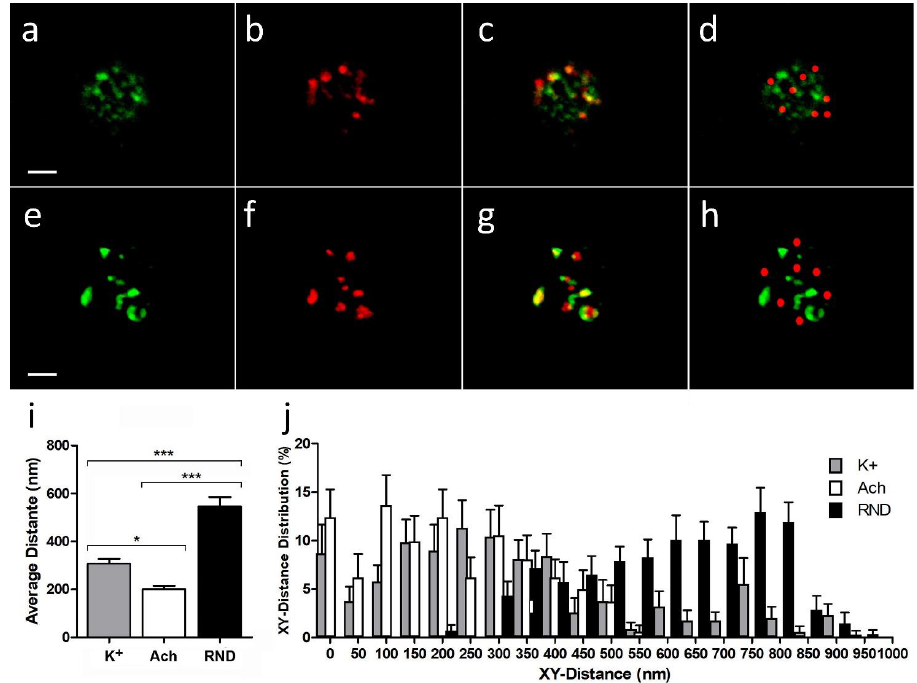
Figure 2. Membrane proximity between endogenous (real) or random simulated α3β4 nAChRs (red) and DBH exocytosis patches (green) upon K + or ACh secretion stimulus. α3β4 nAChR real struc- tures are apparently in contact with DBH exocytotic points more than what would be expected for a random distribution. ( a – d ) A chromaffin cell with both green DBH ( a ) and red α3β4 nAChR ( b ) immunolabeling in a secretion stimulus assay using depolarization with high K + (see Section 4.5). Many of the real α3β4 nAChR (red) structures seem to have at least one pixel that colocalizes with DBH green patches ( c ). The random distributions of the same number of red simulated α3β4 nAChR patches are compared ( d ). ( e – h ) A similar experiment but using ACh as the secretion stimulus (see Section 4.5). Real ( g ) and random simulated ( h ) α3β4 nAChR structures are compared. Many of the red α3β4 nAChR structures ( f ) seem to have at least one pixel that colocalizes with DBH green patches ( g ). Significant differences are seen in the mean distance between each patch centroid and the nearest DBH centroid ( i ) (one-way ANOVA Kruskal-Wallis test (non-parametrical), K + to ACh: p * < 0.05 moderately significative; K + to RND and ACh to RND p *** < 0.0001 highly significative). The distribution of XY distances confirms these tendencies in each condition ( j ): under K+ stimula- tion (grey fill), 323 real α3β4 nAChR structures from 24 cells are measured. Under ACh stimulation (white fill), 325 real α3β4 nAChR structures from 30 cells are measured. Similar number (306) of simulated α3β4 nAChRs are measured to obtain the random distribution. Bars represent 2 μm. These results suggest that, upon secretory stimuli, α3β4 nAChR structures appear significantly closer to the active secretory sites than that expected for the random distri- butions, and that ACh stimulation is particularly effective at moving nAChRs nearer to the secretory active sites.